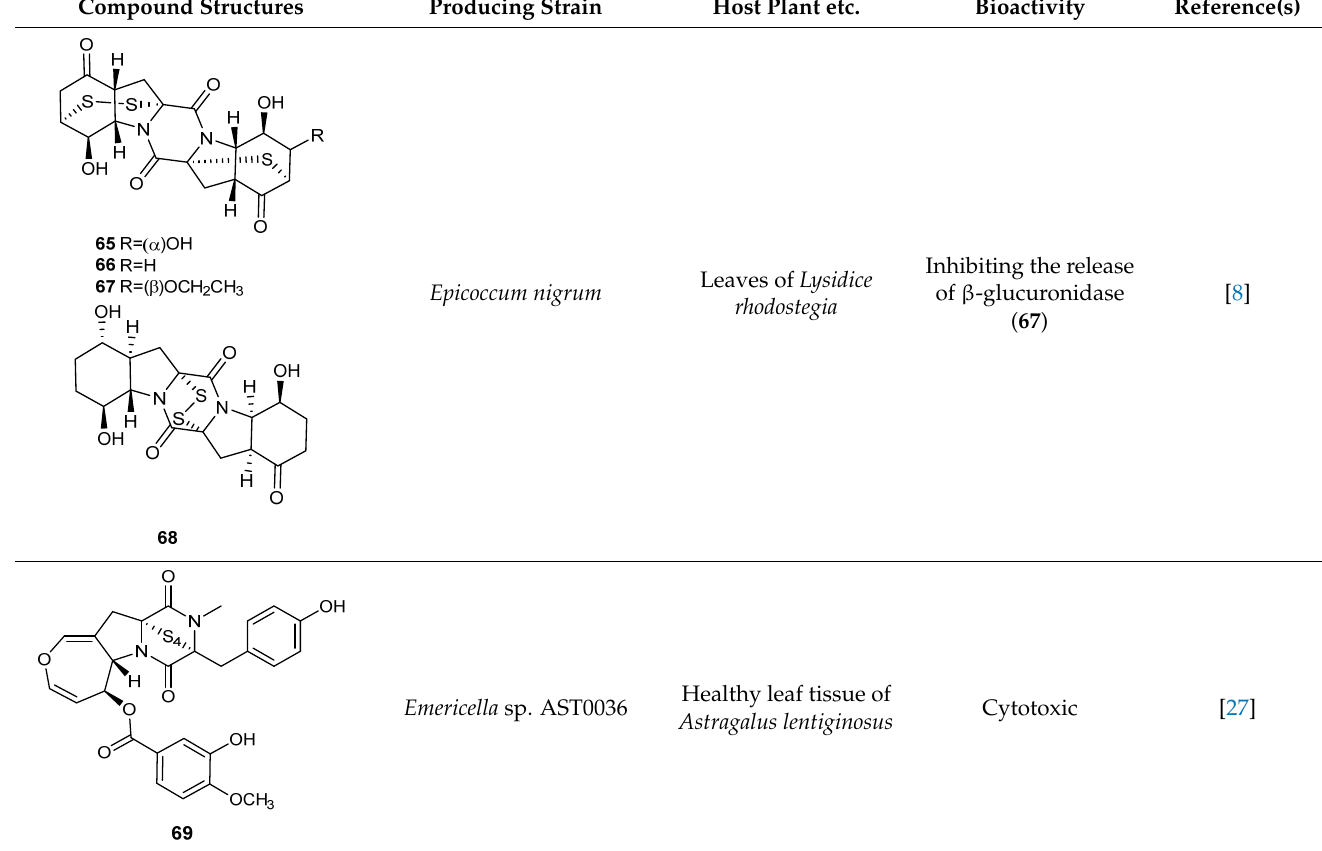
Table 1. Cont . Compound Structures Producing Strain Host Plant